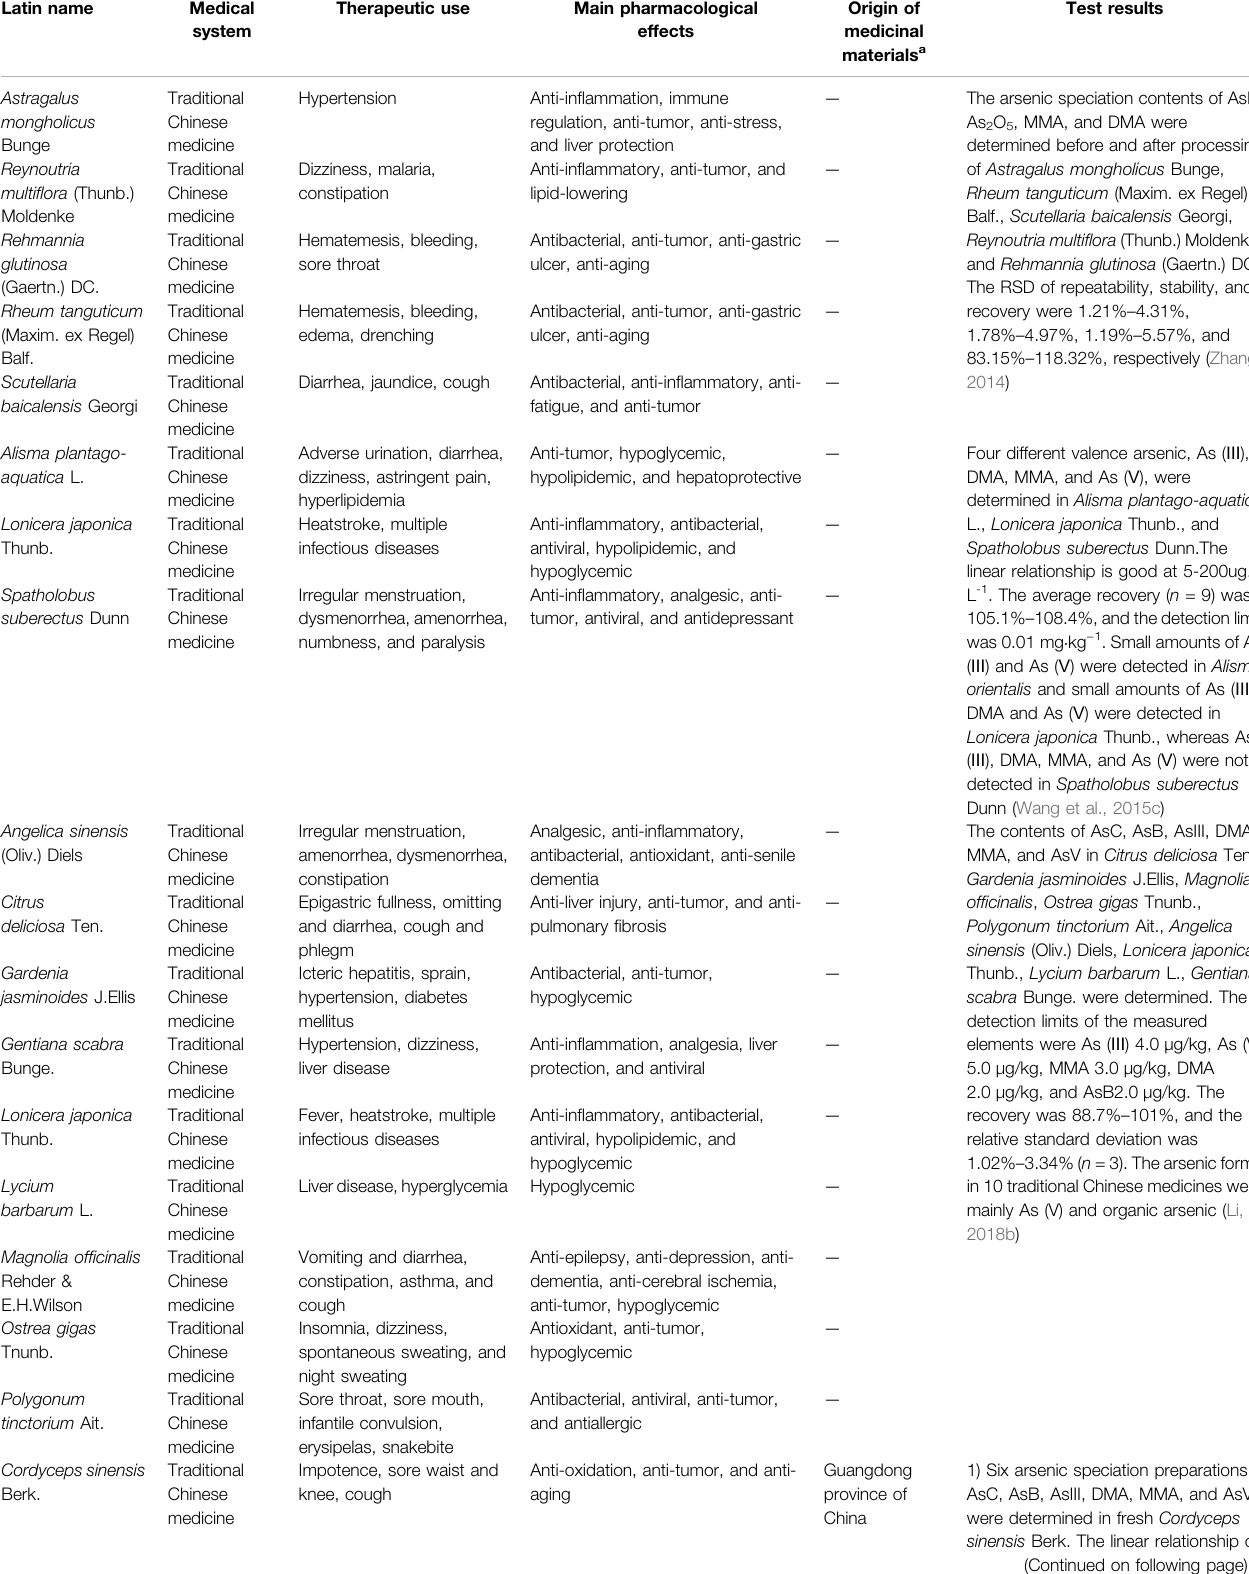
TABLE 11 | Application of HPLC-ICP-MS in medicinal